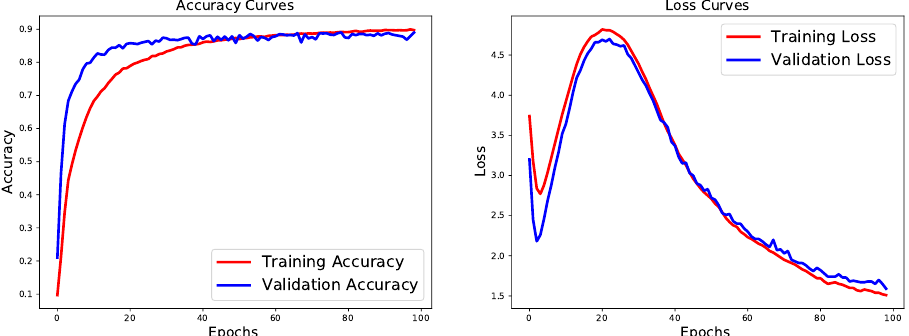
Figure 5. Accuracy and loss evolution during the training and validation of the